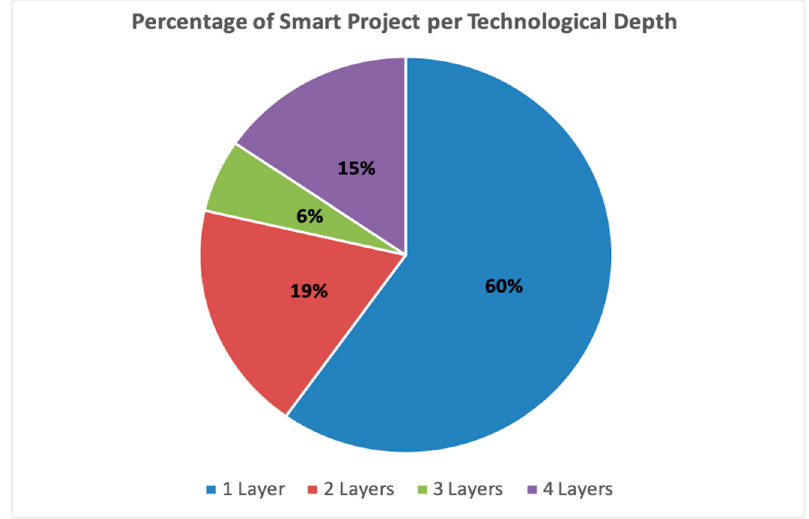
Figure 9. Percentage of smart project per technological depth.